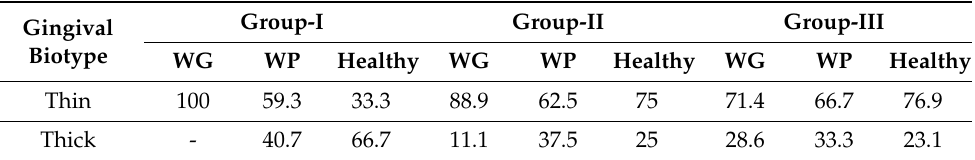
Table 4. Prevalence of gingival biotype in the observation groups.